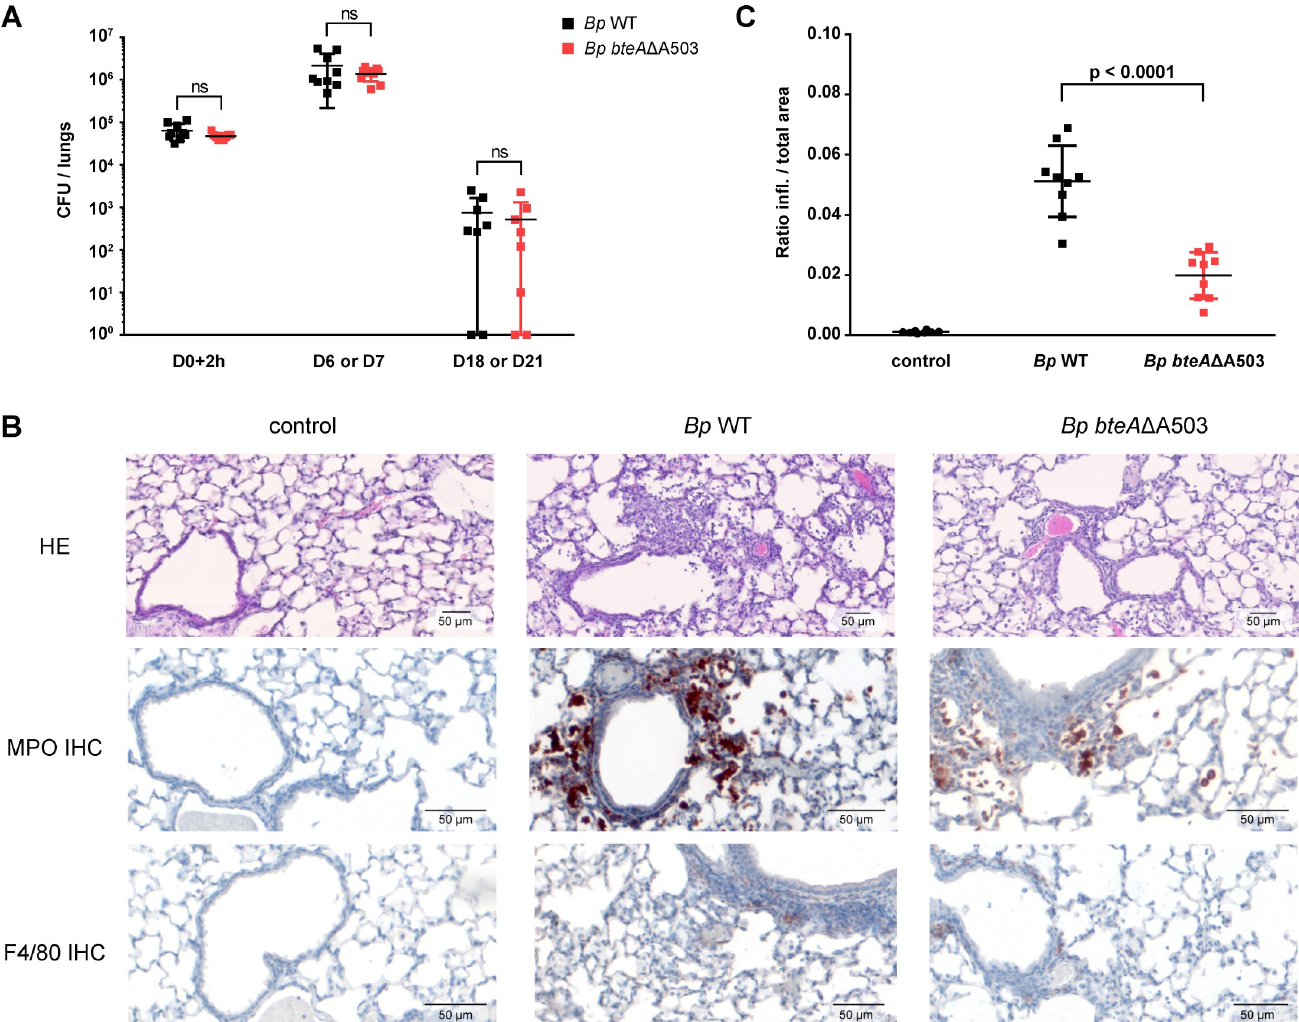
Fig 4. Deletion of Ala503 residue from Bp BteA effector protein limits B . pertussis -induced bronchopneumonia. (A) The B . pertussis bteA Δ A503 derivative strain colonizes mice lungs as efficiently as wild type strain. Five-week-old female Balb/cByJ mice (3 to 4 mice per time point and group) were intranasally infected with 10 5 CFU of B . pertussis B1917 wild type ( Bp WT) or bteA Δ A503 ( Bp bteA Δ A503), and bacterial load in their lungs was determined. Data are pooled from 3 independent experiments, and points represent CFUs counts of individual lungs at indicated days (D) after the exposure to challenge suspension. The determination was performed in exp.1 on D0+2h, D6, D18, in exp.2 on D0+2h, D6, D21, and in exp.3 on D0+2h and D7. The means ± SD are shown (n = 8 to 9 per time point and group). ns, not significant, Bp WT vs. Bp bteA Δ A503, unpaired two-tailed t -test. (B-C) Deletion of Ala503 residue from Bp BteA effector protein limits B . pertussis B1917-induced bronchopneumonia. Mice infected intranasally with 10 5 CFUs of Bp WT or Bp bteA Δ A503 were sacrificed on day 6, and their lung tissue was examined upon hematoxylin and eosin (HE) staining. The presence of neutrophils and macrophages was revealed by myeloperoxidase (MPO) and F4/80 immunohistochemical (IHC) staining, respectively. (B) Representative images of lung parenchyma. (C) Regions of the lung parenchyma containing inflammatory infiltrate were manually delimited in a blinded manner on 12 consecutive HE-stained lung sections for each animal, and the ratio of inflamed (infl.) to total parenchyma areas was calculated for each lung. Data shown are from 2 independent experiments, each containing 5 mice per group (n = 10). The mean value ± SD is shown. p < 0.0001, Bp WT vs. Bp bteA Δ A503, unpaired two-tailed t